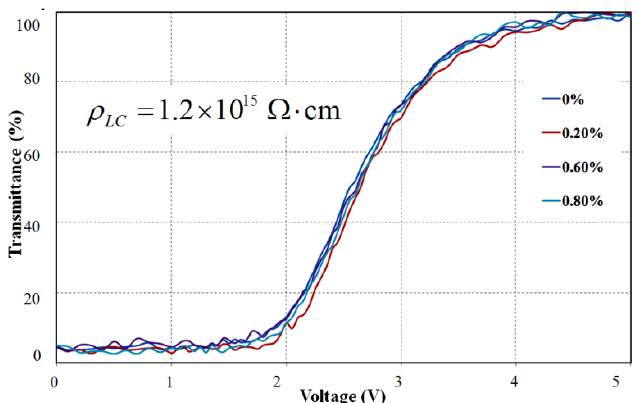
Figure 9. The normally black V-T curves for samples with higher resistivity, where the x -axis represents the root-mean-squared voltage of the applied bipolar square wave and the y -axis indicates the normalized